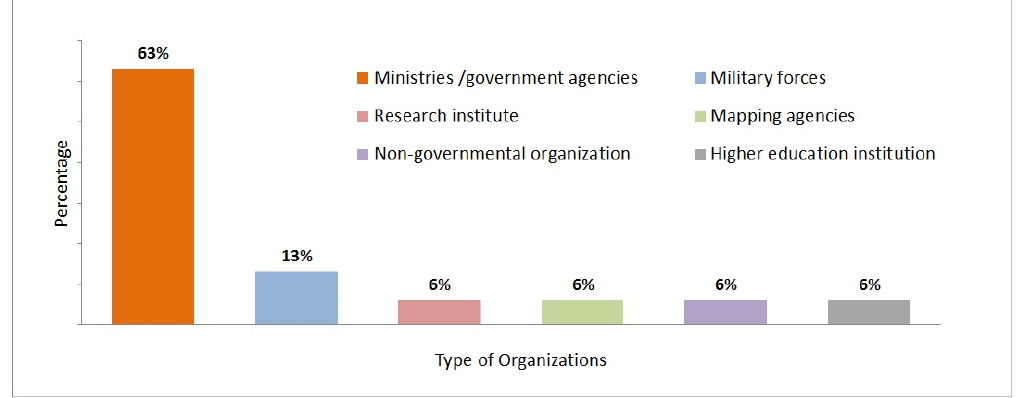
Figure 6. Distribution of responses by type of organization (Q2) .